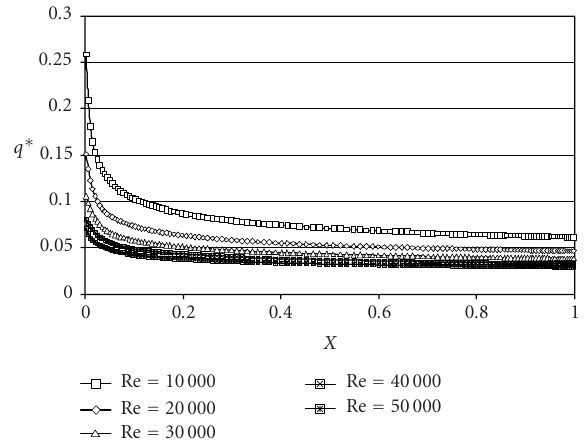
Figure 9: Nondimensional heat flux distribution along the bottom wall of the cooling channel for ˙ m r = 1 / 1 and di ff erent Reynolds